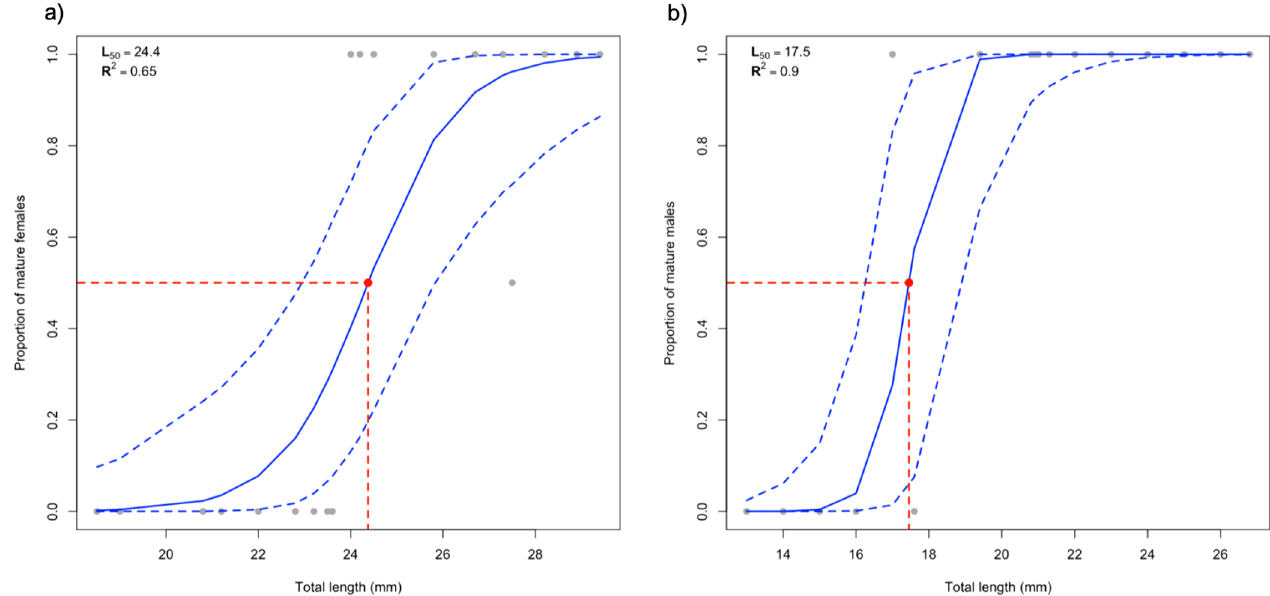
Fig. 6. The size at sexual maturity for a) Females and b) Males where the L 50 (dashed red line) represents the length at which a randomly chosen specimen has a 50% chance of being mature. The fi tted values for the logit regression (with the R 2 value) and con fi dence intervals (95%) are represented by solid and dashed lines